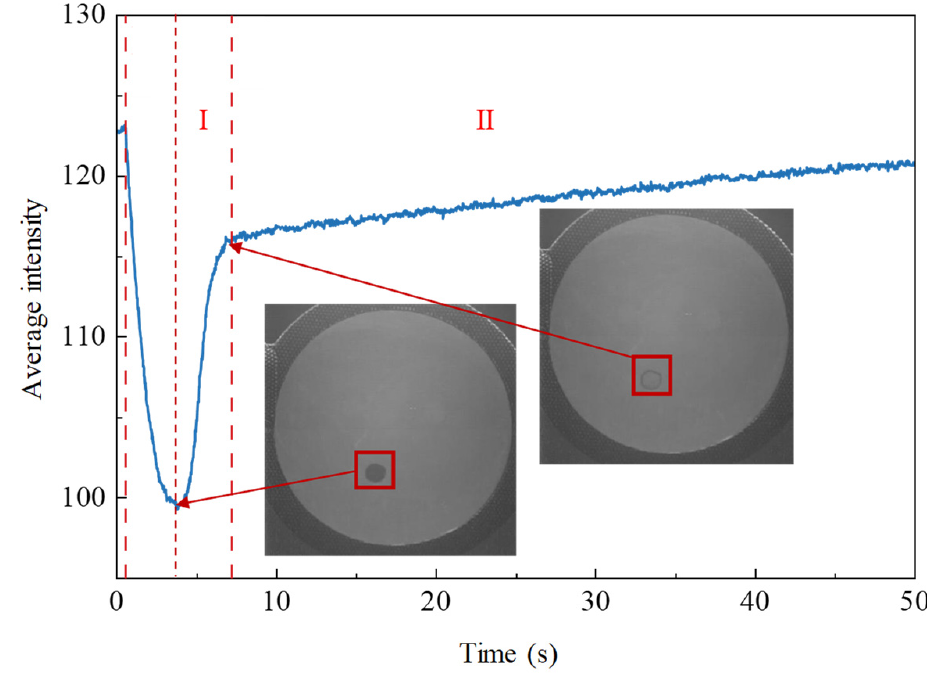
Figure 4. Evaporation curve of methanol and n-octanol mixed solution after deposit. Further, the experiment was repeated with deposited different total volumes of mixed solution, many times. The volume and mixing ratio of mixed solution used are given in Table 3. Table 3. The volume and mixing ratio of mixed